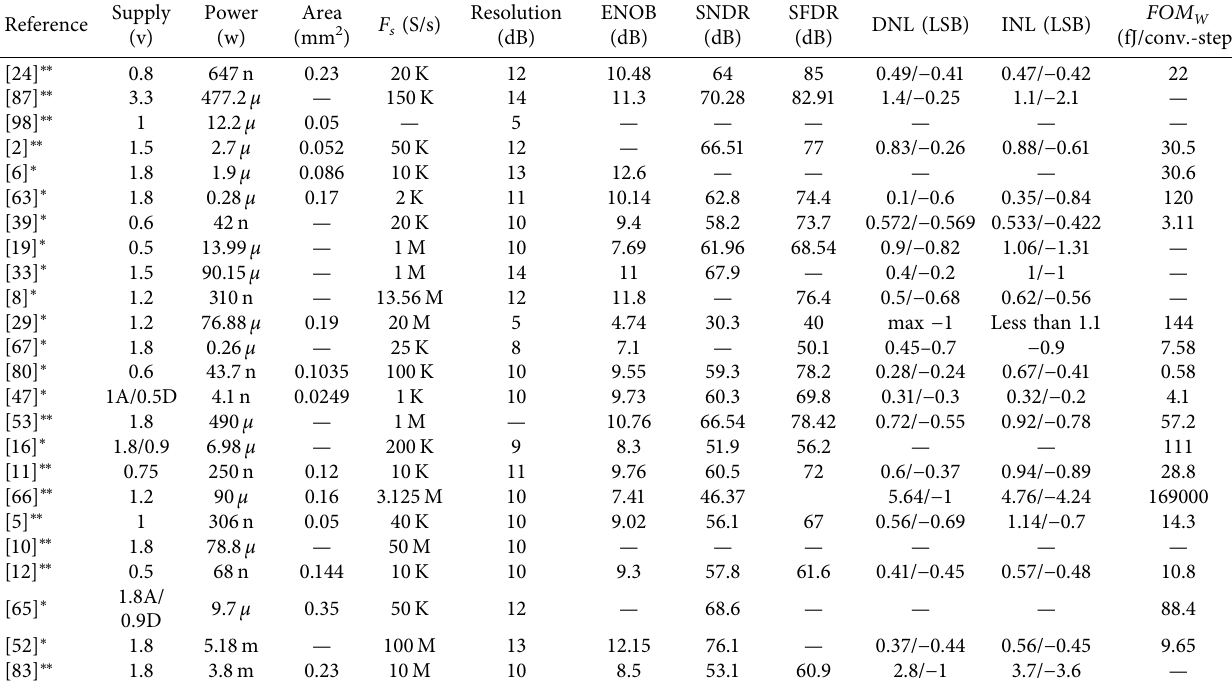
Table 4: Summary of the recently published SAR ADC performance parameters in 180nm process. Supply Reference (v)